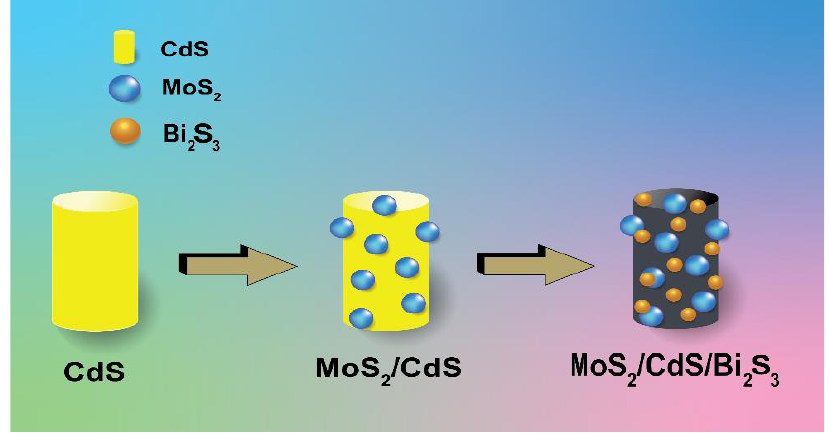
Figure 11. Product of CdS/MoS 2 /BiS